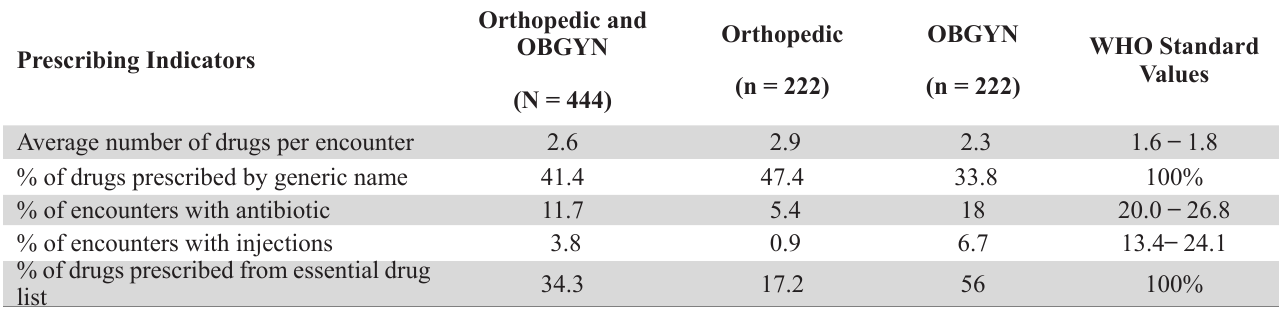
Table 2: WHO Core Prescribing Indicators of